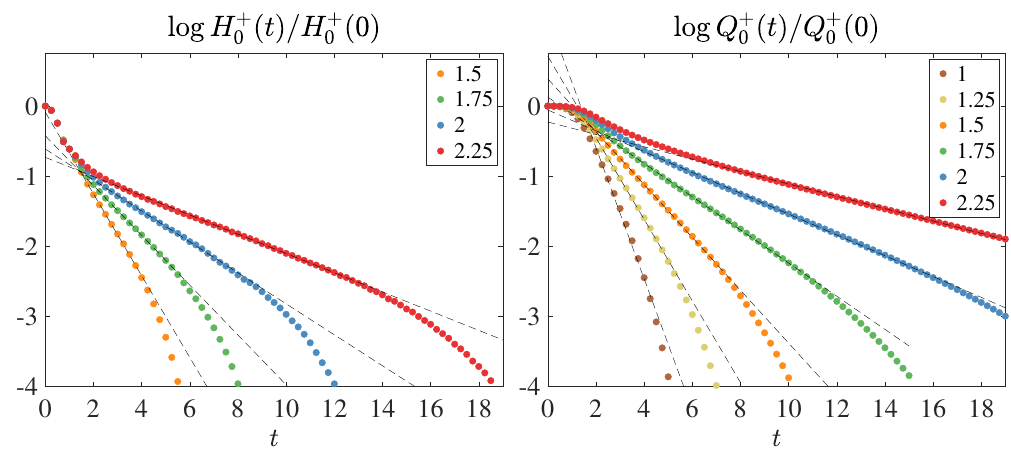
( t ) and Q + ( t ) normalised by their value at t = 0 for 0 0